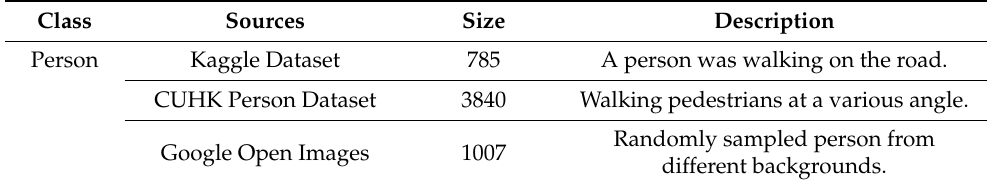
Table 4. Datasets description.